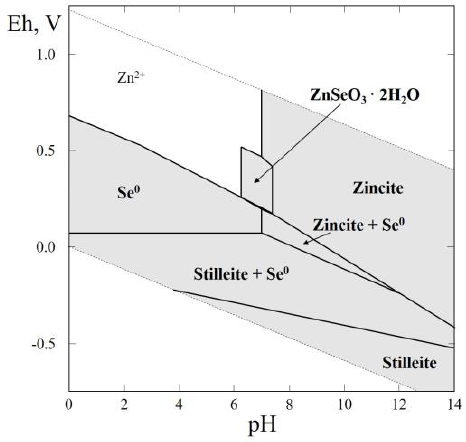
Figure 7. Eh–pH diagram of the OHSeZn (Zn–Se–H 2 O) system at 25 ◦ C and the activities of the Figure 7. Eh – pH diagram of the OHSeZn (Zn-Se-H 2 O) system at 25 °С and the activities of the components: a Σ Se = 10 − 4 , a Σ Zn = 10 − 2 components: a ΣSe = 10 − 4 , a ΣZn = 10 − 2 .